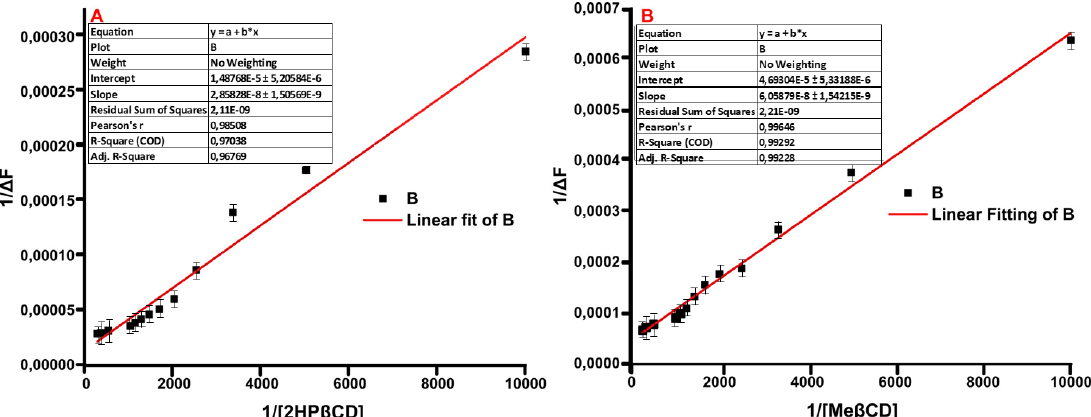
Figure 10. Double-reciprocal plots of the QUE titration with various concentrations of CDs (0, 0.1, 0.2, 0.3, 0.4, 0.5, 0.6, 0.7, 0.8, 0.9, 1.0, 2.0, 3.0 and 4.0) ( A ) 2HP- β -CD and ( B ) 2,6Me- β -CD.